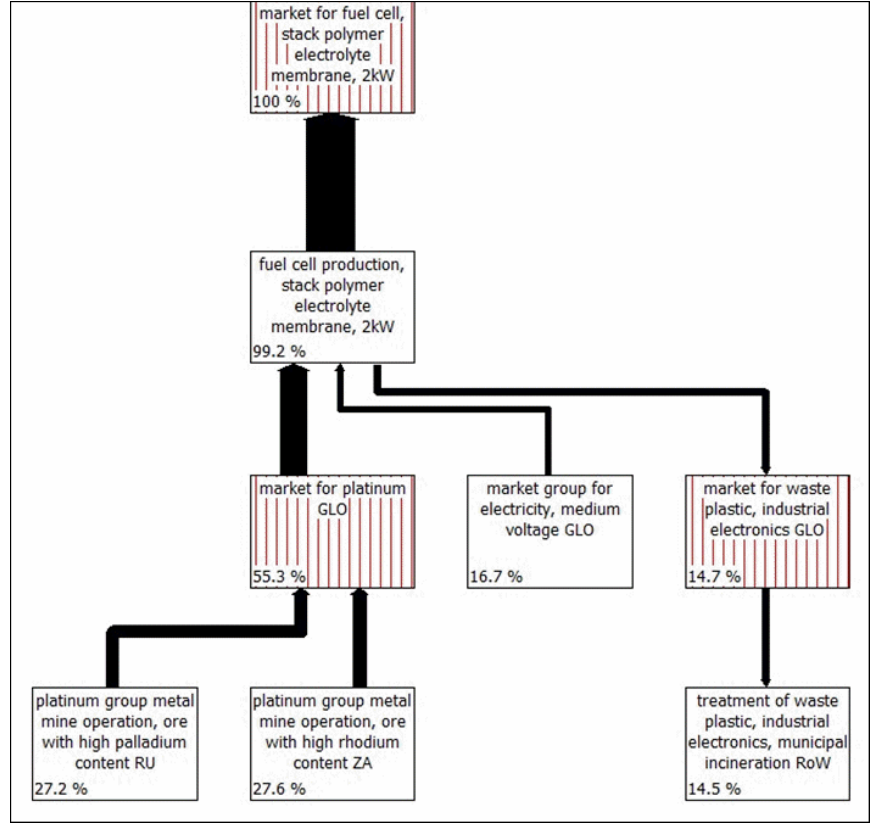
Figure 11. Environmental impacts flowchart for the PEM fuel cell.